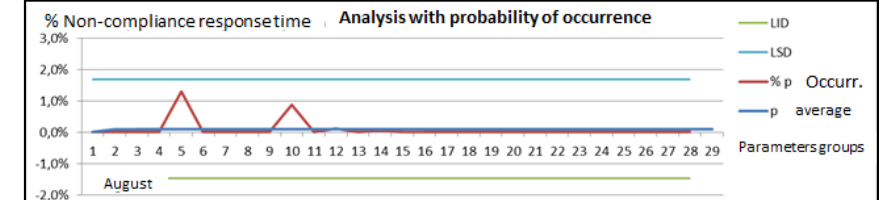
Figure 5. Analysis with probability of occurrence of low probability events according to Swertward [30]. Probability of occurrence of measurements that exceeded the turnaround time per parameter during the month of August. On the 30th and the 31st it didn’t have not any activity (Saturday,